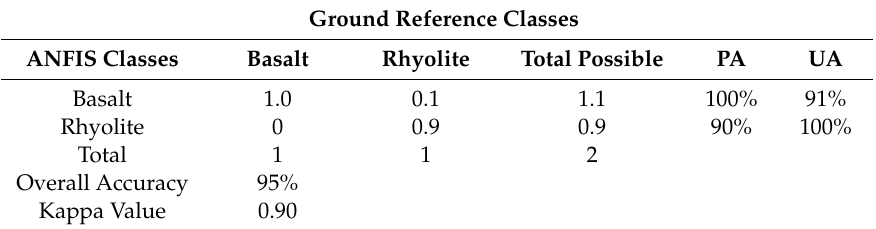
Table 2. Normalized accuracy assessment of data without basaltic